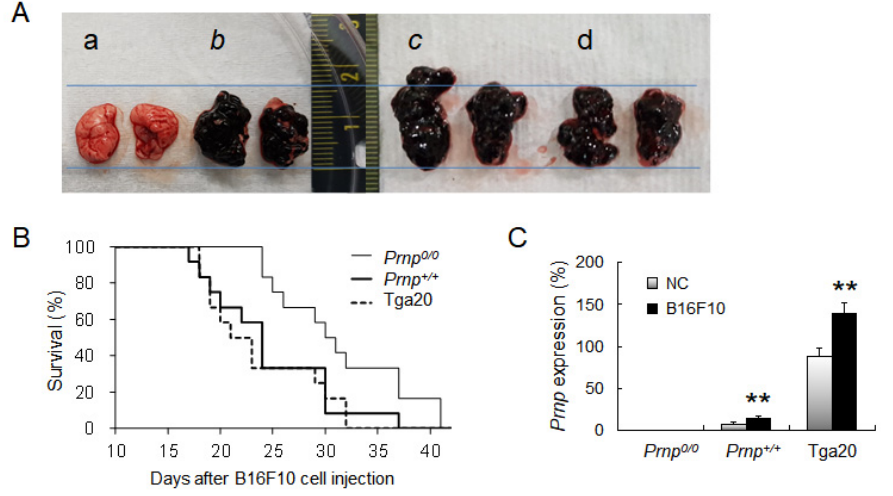
Figure 1. The terminal stage of lung cancer induced by B16F10 melanoma cells of Prnp 0/0 , Prnp +/+ , and Tga20 mice. ( A ) Representative images of tumours. (a) Negative control. (b–d) The lungs at the terminal stage of cancer from Prnp 0/0 (b), Prnp +/+ (c), and Tga20 (d) mice. ( B ) Survival curve for mice with metastatic lung cancer. ( C ) mRNA levels for Prnp in whole splenocytes. NC: Negative control group; B16F10: Group with lung cancer induced by B16F10 melanoma cells. mRNA expression was normalised to Actb expression (100%). These results are for an average of 12 mice per group. Error bars represent mean values ± standard deviation. ** p < 0.01.